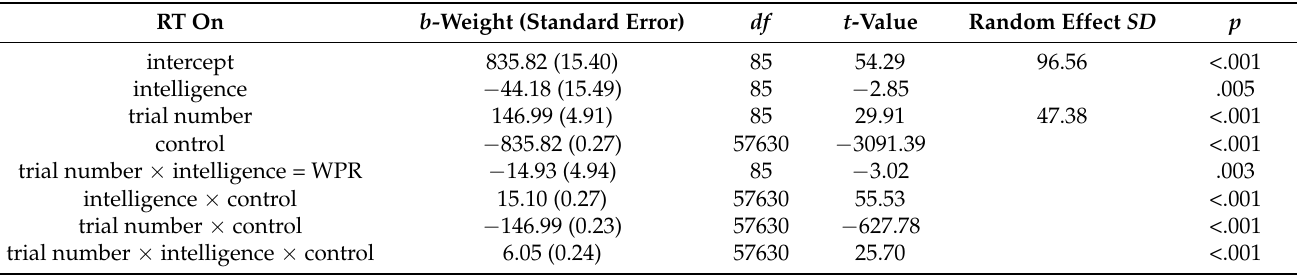
Table 4. Full multilevel model, which tests the effect of attentional lapses covariates (TUTs + Q-SMW + MRT) on the WPR on an unstandardized